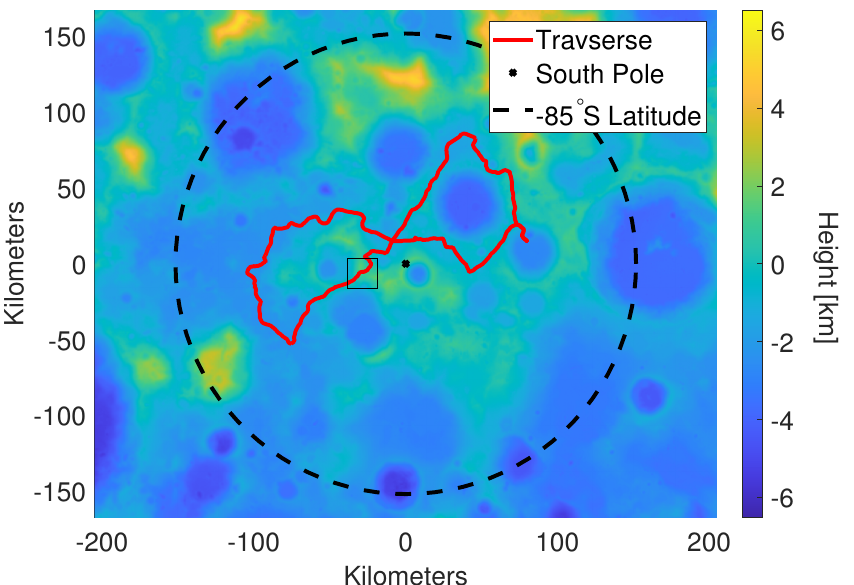
Figure 1. Lunar South Pole traverse shown on top of a low resolution DEM (100 m/pixel) available at the LOLA Planetary Data System (PDS) archive [27], while the small square indicates the region for which a high resolution DEM at 5 m/pixel is available. Projection is polar stereographic where (0, 0) denotes the South Pole.